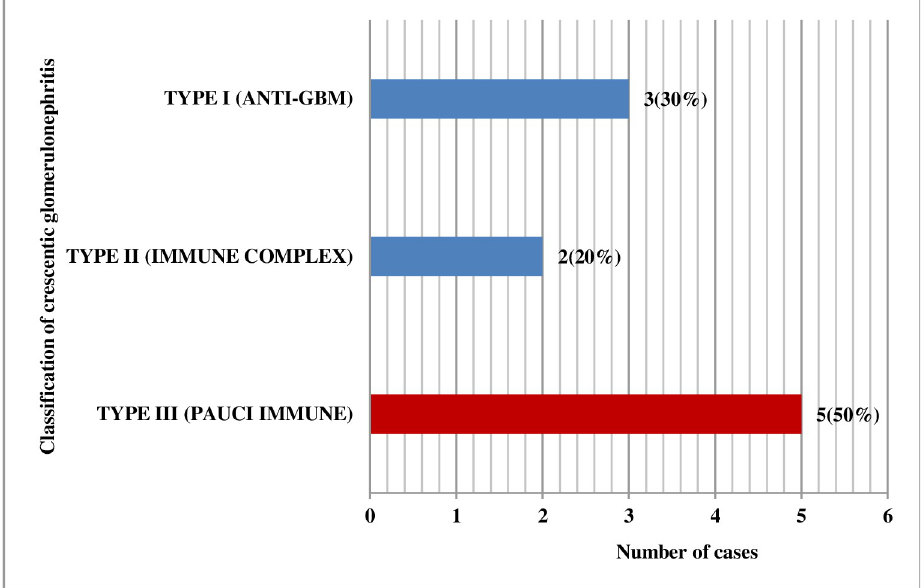
Fig 5. Classification of crescentic glomerulonephritis (N =